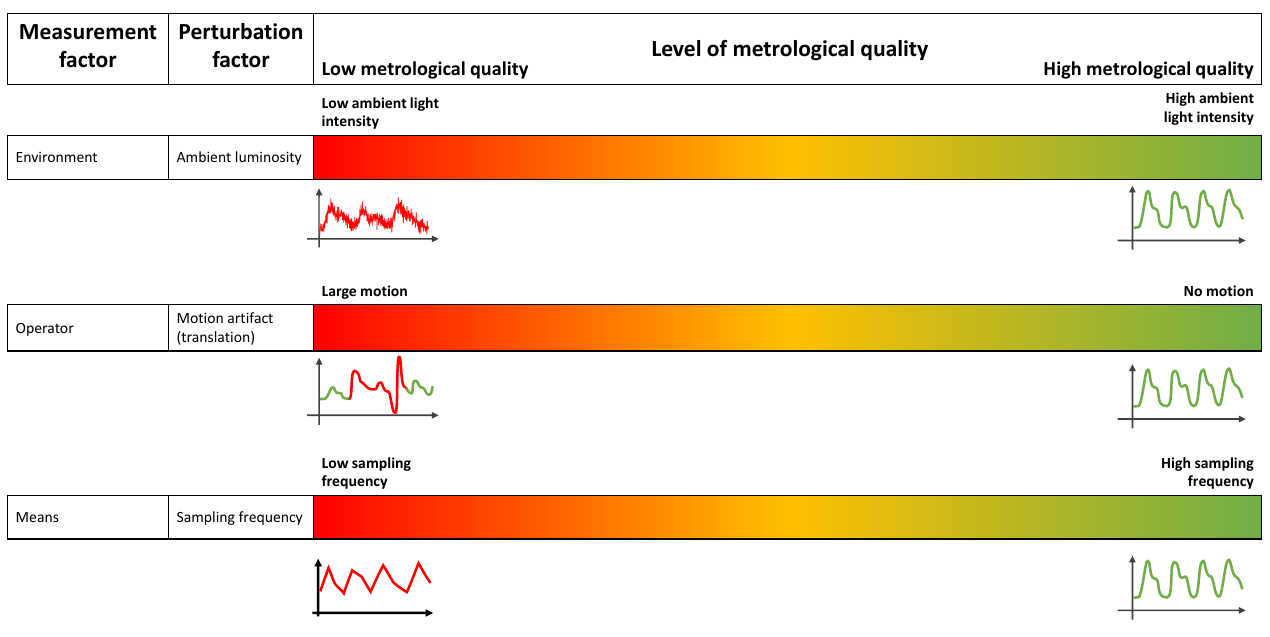
Figure 2. Non-exhaustive example of perturbation factors influencing the metrological quality. For each perturbation, the color bar represents the metrological quality of the signal. Signals tending to the red color have low metrological quality and will have high metrological quality when tending to the green color. Depending on the intensity of the perturbation factor, it has an influence on how well the signal retrieved from the sensor reflects the variation in blood volume in